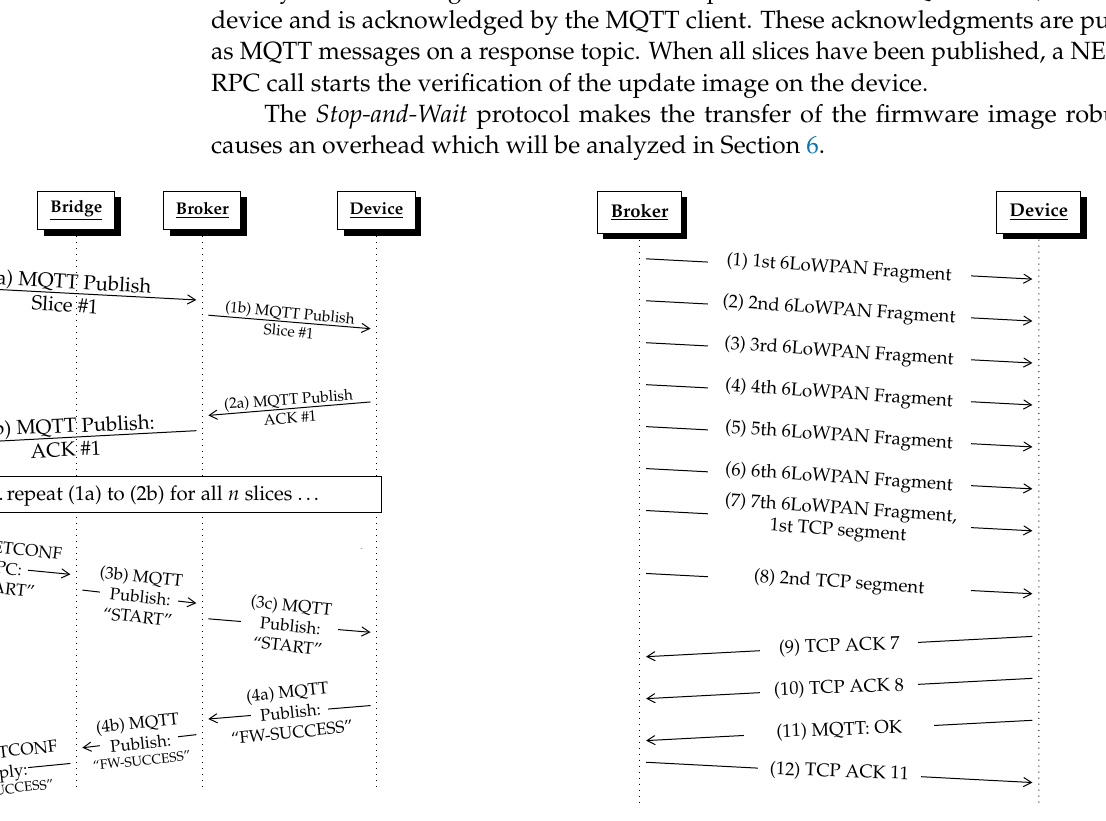
Figure 5. Sequence of packets sent during the transmission of a complete update file (slices 1 to n ) ( left ). Each slice is fragmented by the 6LoWPAN Router ( right ). Example for slice size of 600